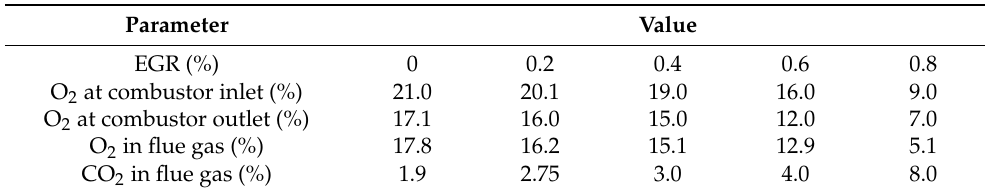
Table 6. Influence of EGR ratio on O 2 molar fraction at the combustor inlet and outlet, and on the CO 2 and O 2 molar fraction in flue gas (adapted from [71]).